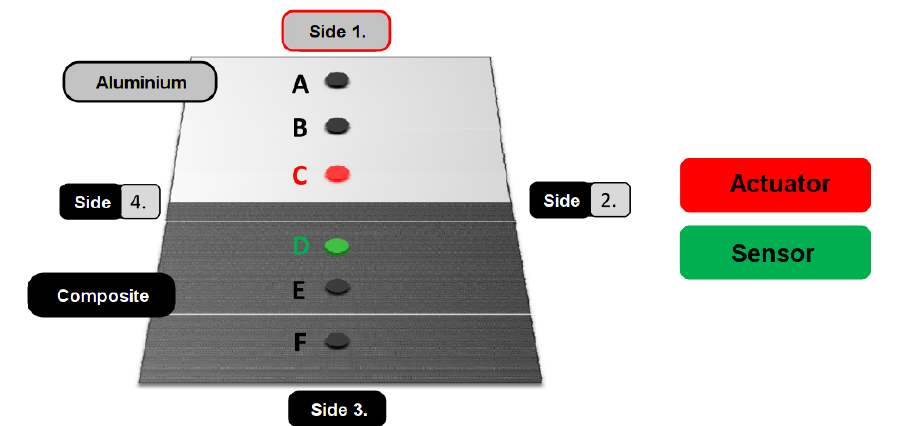
Figure 3. Experimental setup and placement of PWAS; in this case the transmitted signal from position C to position D is